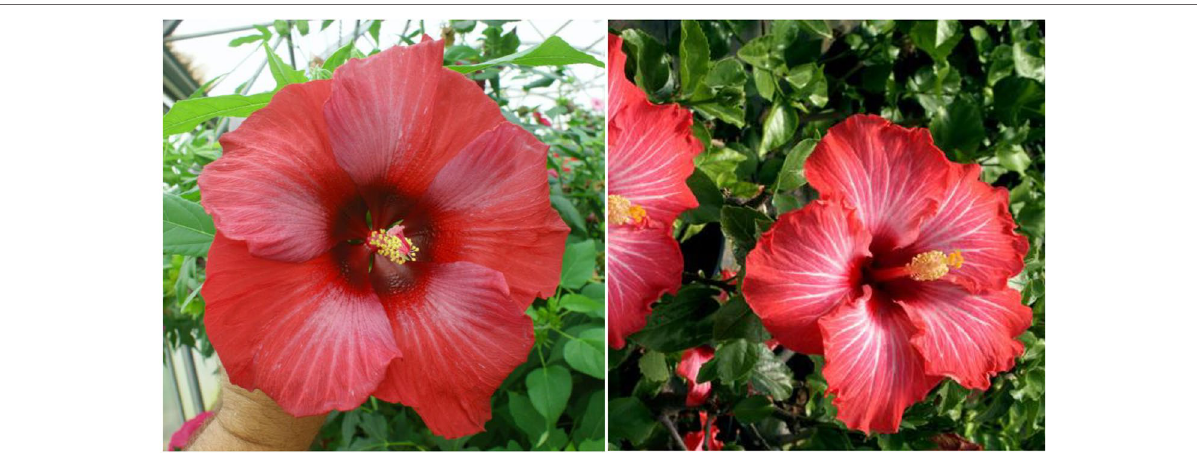
FIGURe 6 | Flower color and shape of H. x moscheutos hybrid “15681-1GR” (left) and H. rosa-sinensis “Chariots of Fire” (right). Photo credits: Dariusz P. Malinowski (“15681-1GR”) and Cindy Black (“Chariots of Fire”), Hidden Valley Hibiscus. Used with permission.